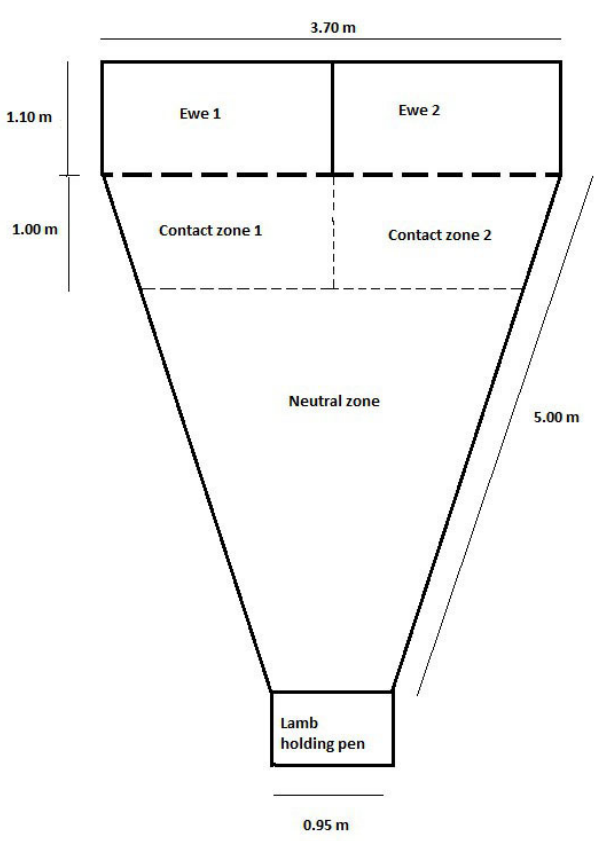
Figure 1. Layout of testing arena and holding pens for the maternal-recognition test. Adapted from